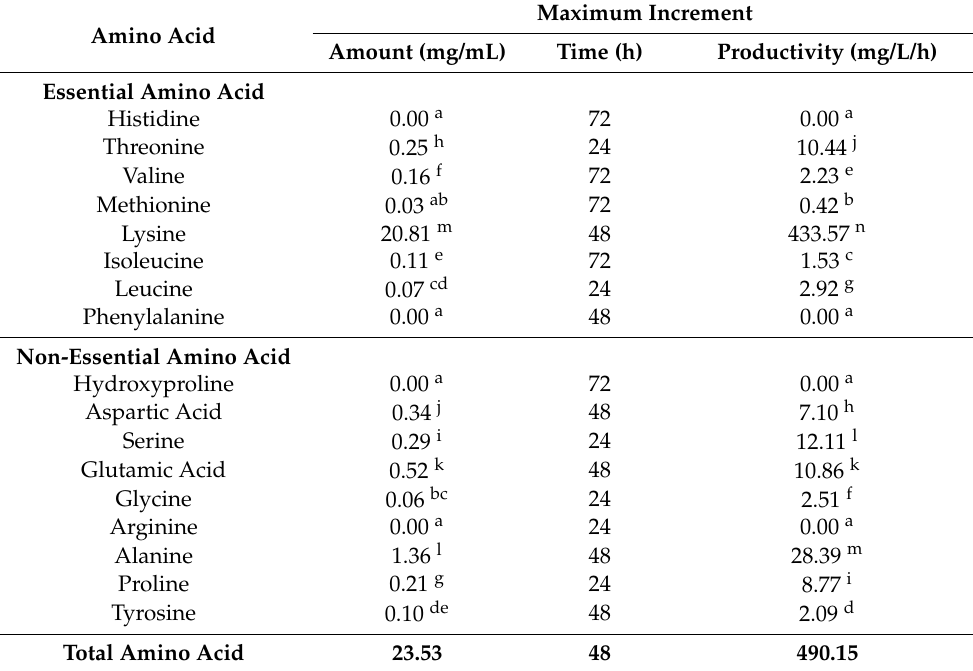
Table 2. Maximum increment in amino acids production from pineapple plant stem hydrolysate through separate enzymatic hydrolysis and fermentation using B. subtilis ATCC 6051. Superscripts with different letter are significantly different from each other within the same column at p ≤ 0.05. Maximum Increment Amino Acid Amount (mg/mL) Time (h) Productivity (mg/L/h) Essential Amino